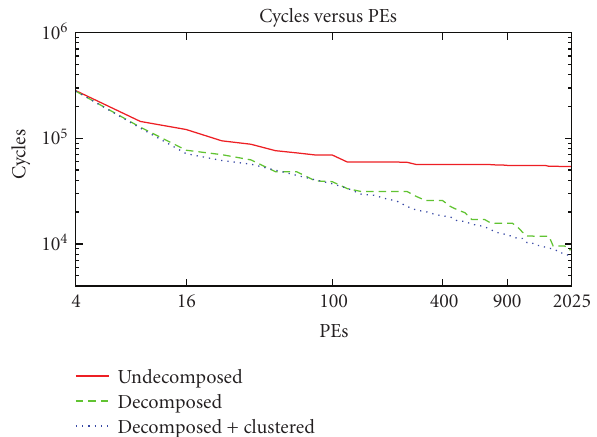
Figure 12: Decomposition and Clustering ( cnet-default